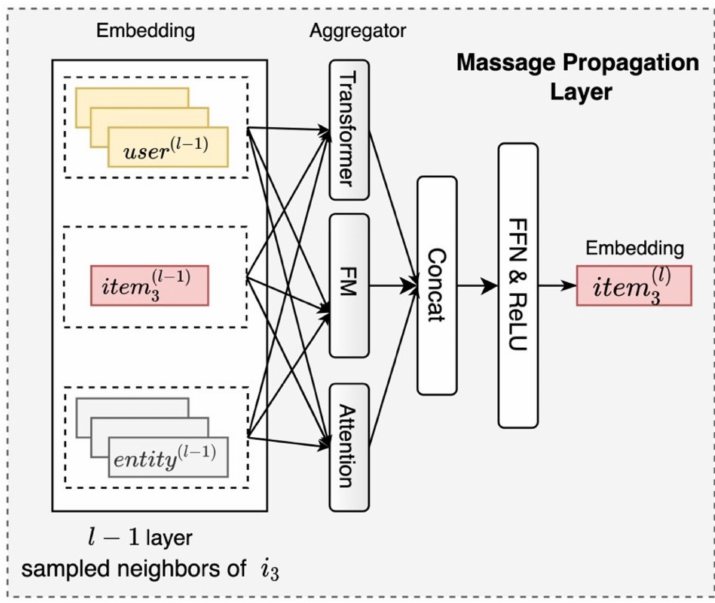
Figure 3. Message propagation